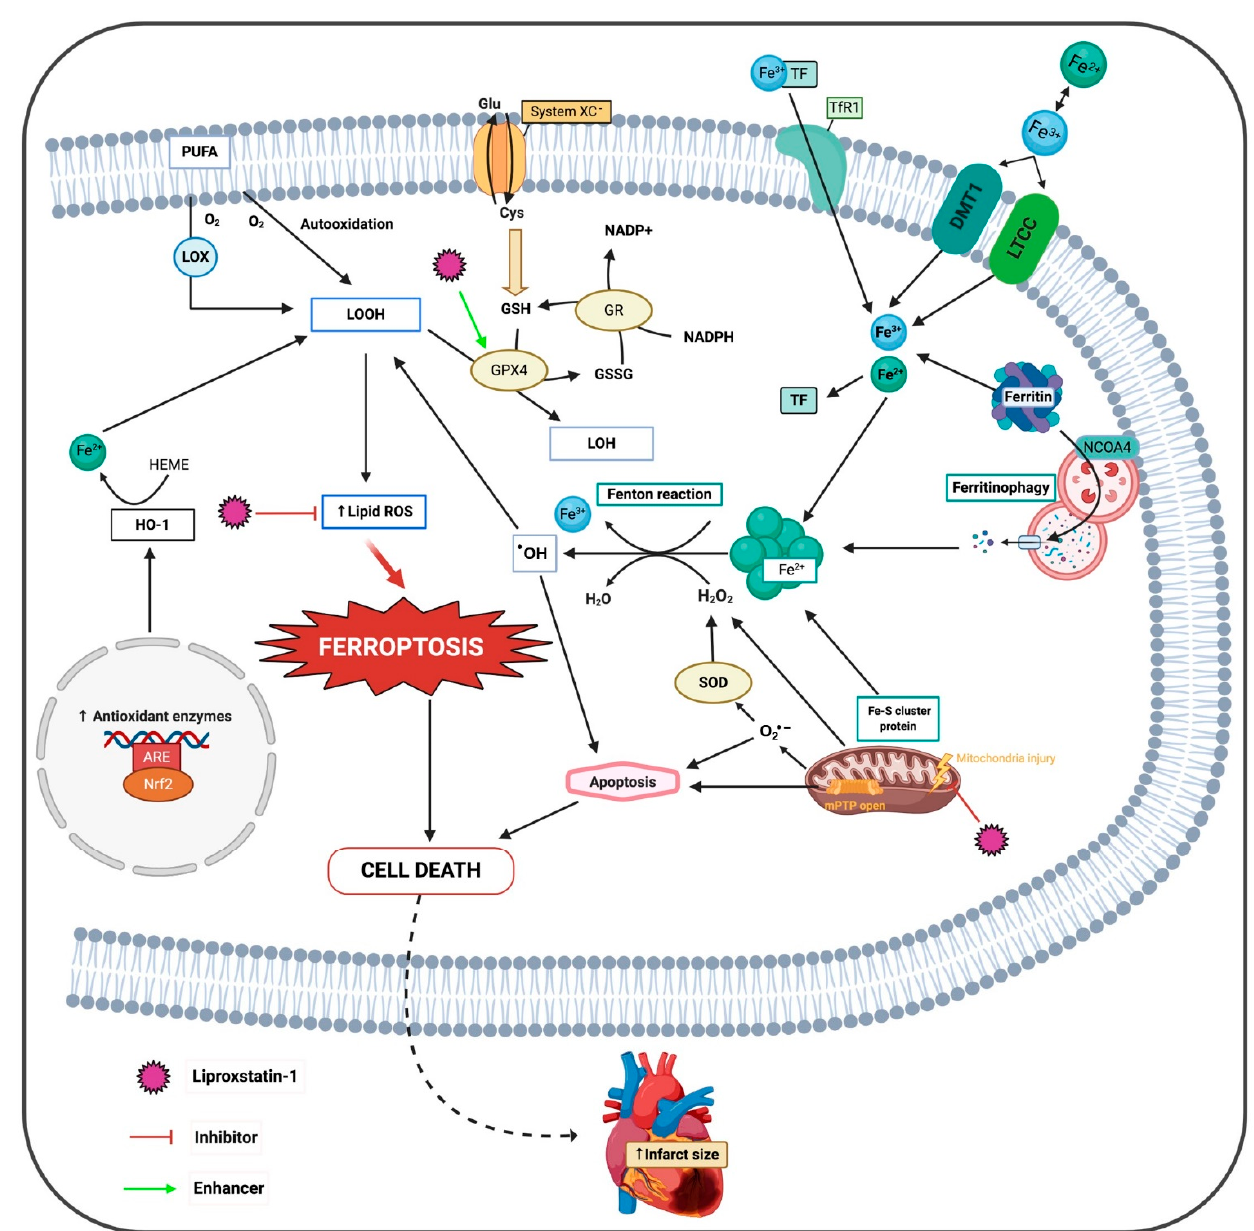
Figure 2. Molecular mechanisms of the deleterious effects of ferroptosis and proposed sites of protective action of liproxstatin-1. ARE, antioxidant response elements; DMT1, divalent metal transporter; Fe 2+ , ferrous iron; Fe 3+ , ferric iron; GPX4, glutathione peroxidase 4; GR, glutathione reductase; HO-1, heme oxygenase 1; H 2 O 2 , hydrogen peroxide; LOH, lipid alcohols; LOOH, lipid hydroperoxides; LOX, lipoxygenase; LTCC, L-type calcium channel; mPTP, mitochondrial permeability transition pore; Nrf2, nuclear factor-erythroid 2-related factor 2; NCOA4, nuclear receptor coactivator 4; O 2 •− , superoxide radical; • OH, hydroxyl radical; PUFA, poly-unsaturated fatty acids; SOD, superoxide dismutase; TF, transferrin; TfR1, transferrin receptor.